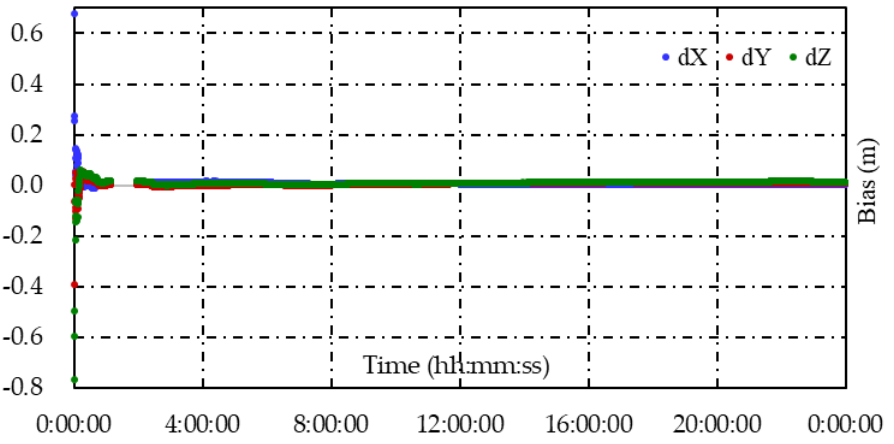
Figure 7. Coordinate biases from static PPP with method B.